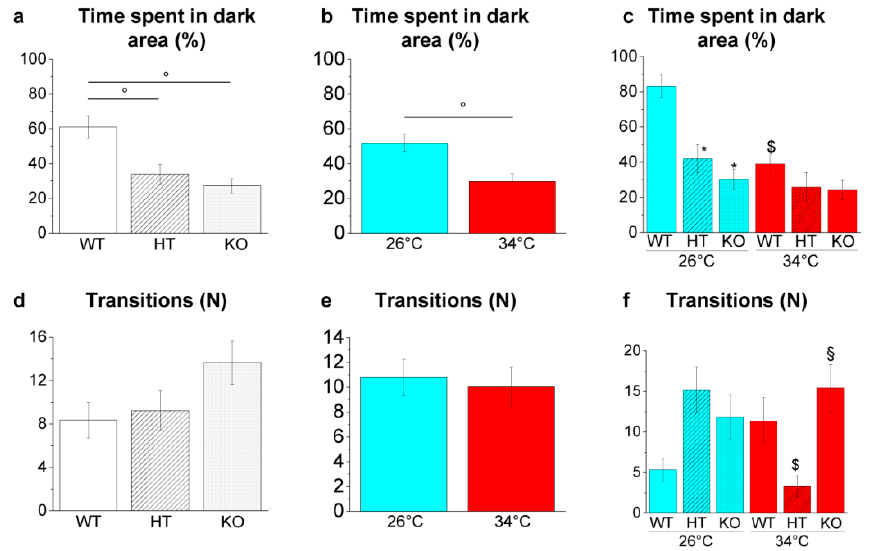
Figure 11. Scototaxis behaviour in the LDT. ( a – c ) Time spent in the dark area; ( d – f ) number of pas- sages between the bright and dark areas. The data are expressed as mean ± S.E.M. and analysed by two-way ANOVA with Bonferroni post hoc correction. p ≤ 0.05, °; *, HT26 vs. WT26 or KO26 vs. WT26; §, KO34 vs. HT34; $, WT34 vs. WT26, HT34 vs. HT26 or KO34 vs. KO26. p values and symbols used in the figure are shown in Table S24. N = 20. Blue and red colours refer to 26 °C and 34 °C, respectively.